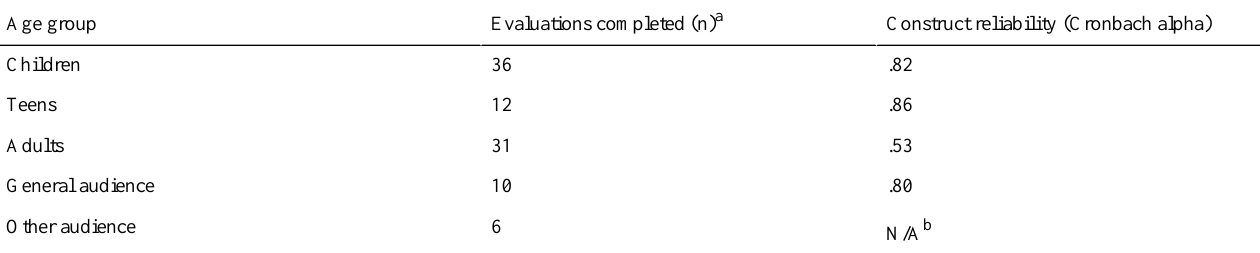
Table 5. Construct reliability of items assessing app appropriateness for evaluator-selected age groups.